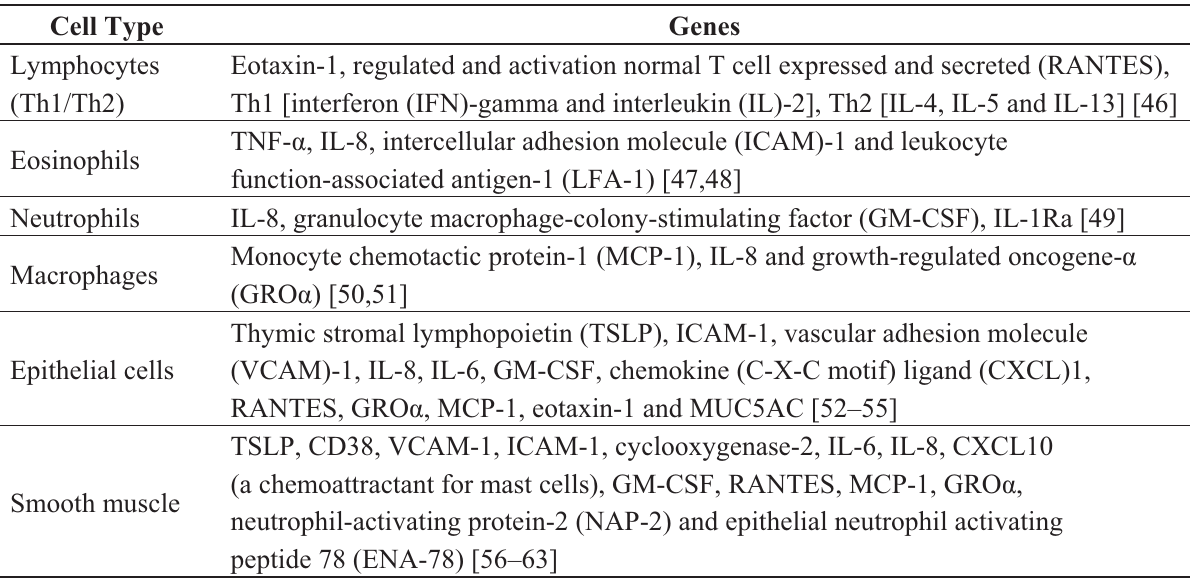
Table 1. Inflammatory genes regulated by NF-(cid:2)B in airway cells